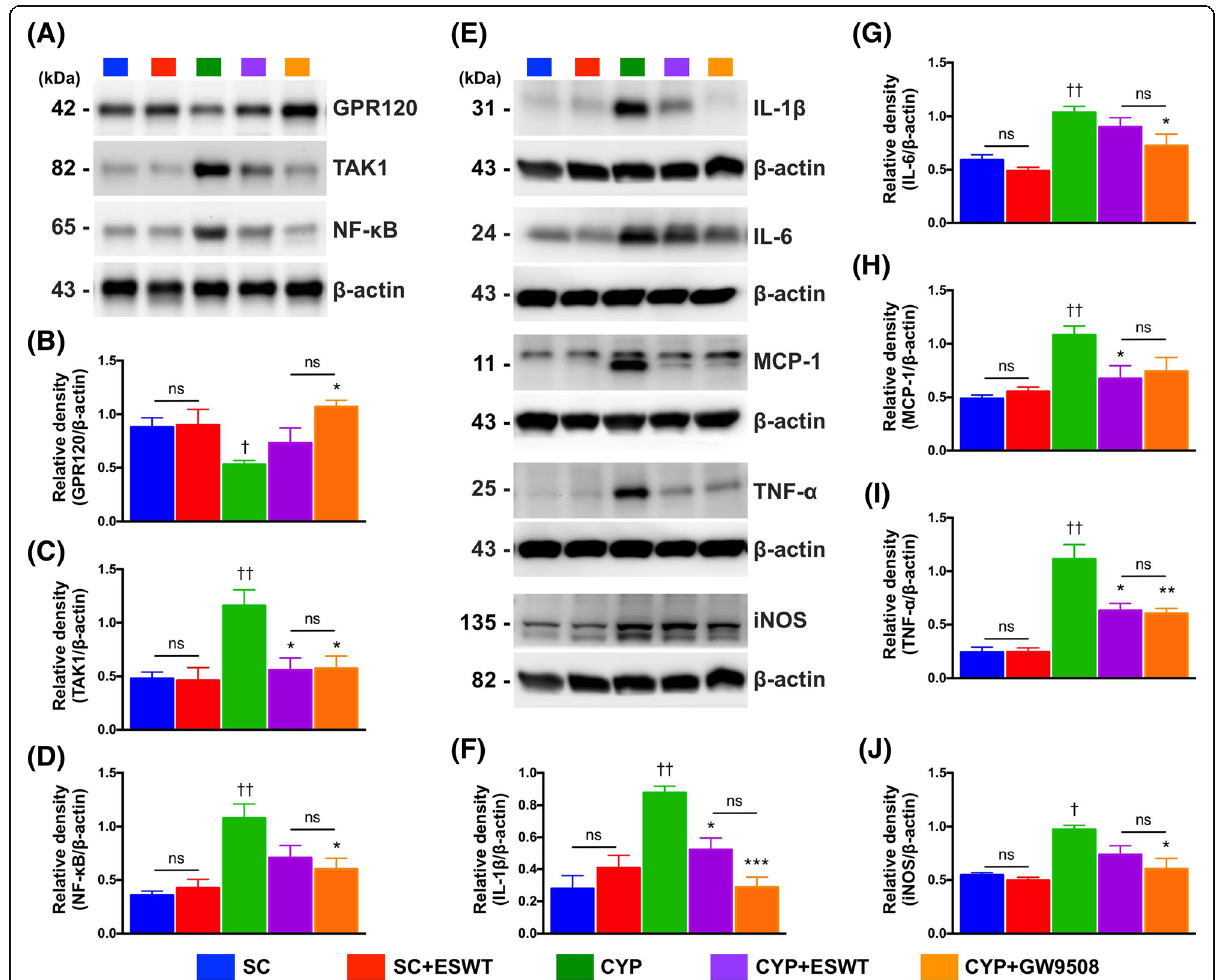
Fig. 9 Expressions of downstream molecules of GPR120- and NF- κ B-signaling pathway in rat urinary bladders following cyclophosphamide (CYP) stimulation with and without GPR120 agonist / extracorporeal shock wave treatment (ESWT). a-d Protein expressions of pro-inflammatory (i.e., TAK1, NF- κ B) and anti-inflammatory (i.e., GPR120) markers. e-j Protein expressions of IL-1 β , IL-6, MCP-1, TNF- α , and iNOS (i.e., downstream molecules of NF- κ B mediated-inflammatory signaling pathway) in CYP-treated rat bladder with and without GPR120 agonist / extracorporeal shock wave treatment (ESWT) ( n = 6 per group). Values expressed as the mean ± SEM. * p < 0.05, ** p < 0.01 vs. CYP; † p < 0.05, †† p < 0.01 vs.